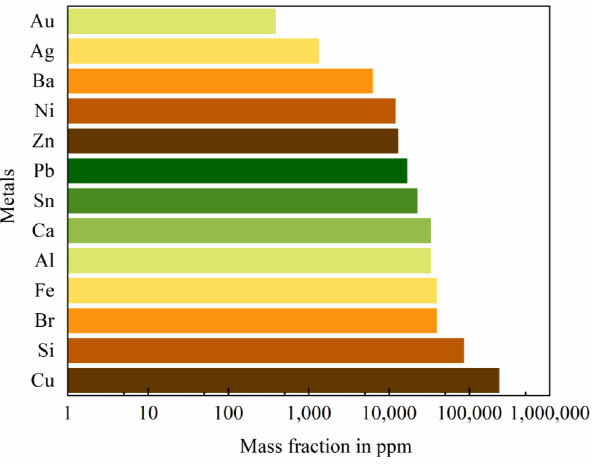
Figure 1. Metal component in WPCBs [6].